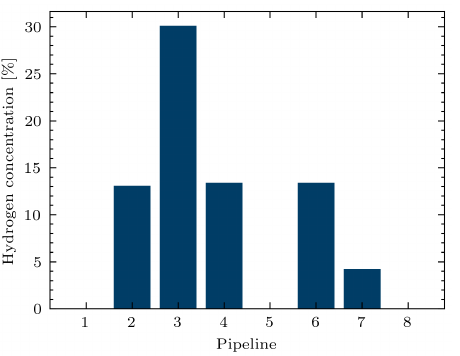
Figure 8. Hydrogen concentration in pipelines with respect to the injection of hydrogen at three